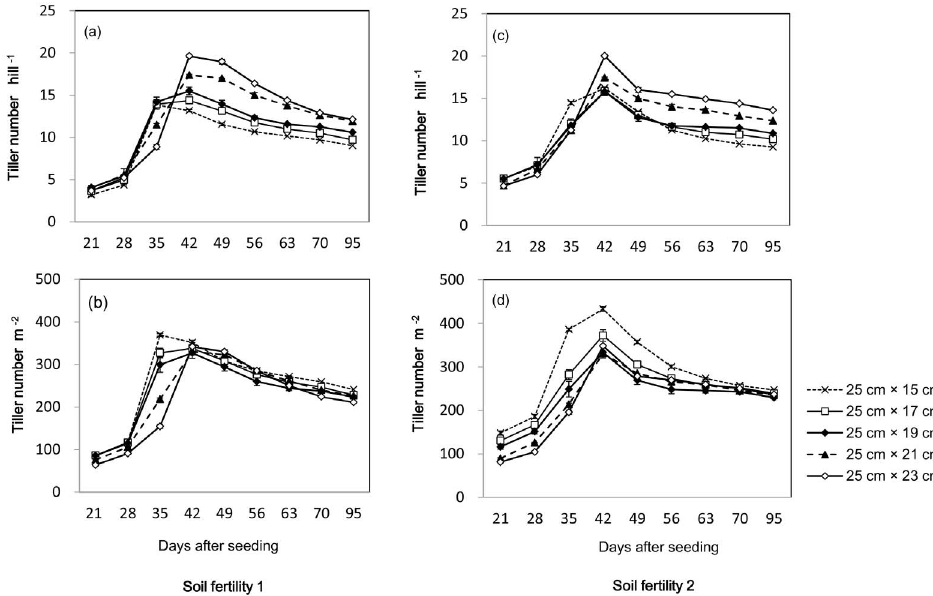
Figure 1. Tillers per hill (a, c) and tillers per m 2 (b, d) of a high-yielding hybrid rice variety Nei2you6 grown at five plant spacings in soil fertility 1 (a, b) and soil fertility 2 (c, d). China National Rice Research Institute, Zhejiang Province, China, 2010.